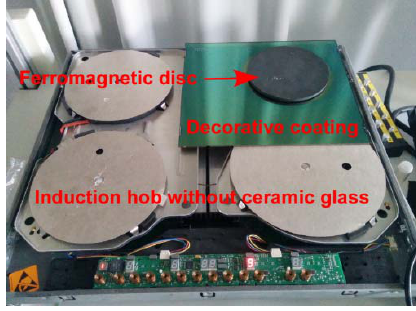
Figure 2. Abandonment test on induction hob with green decorative coating.